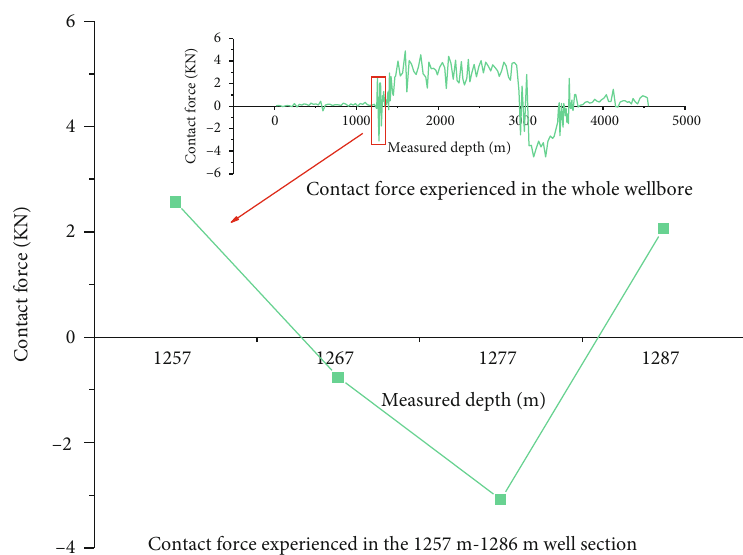
Figure 8: Contact force of the casing string using the improved model.